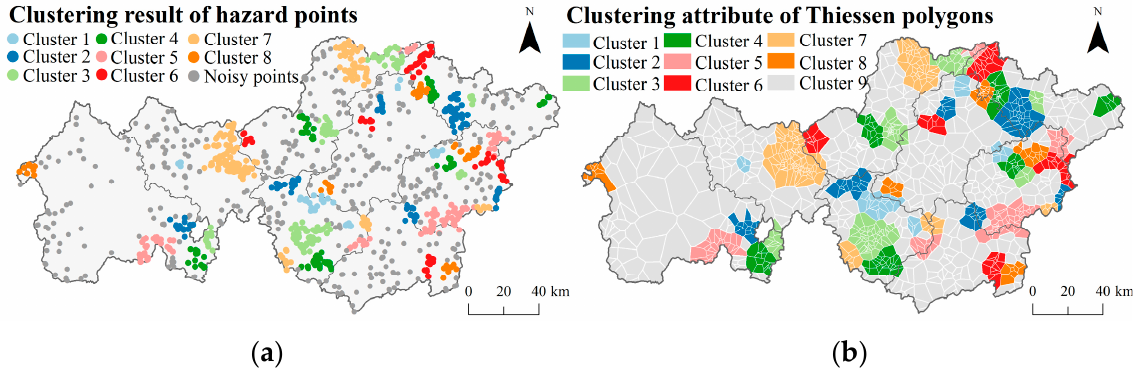
Figure 3. The training accuracy test of different parameter combinations of each model based on OPTICS. ( a ) Training accuracy under different minimum number of points (search distance fixed at 5 km). ( b ) Training accuracy under different search distances (minimum number of points fixed at 6).